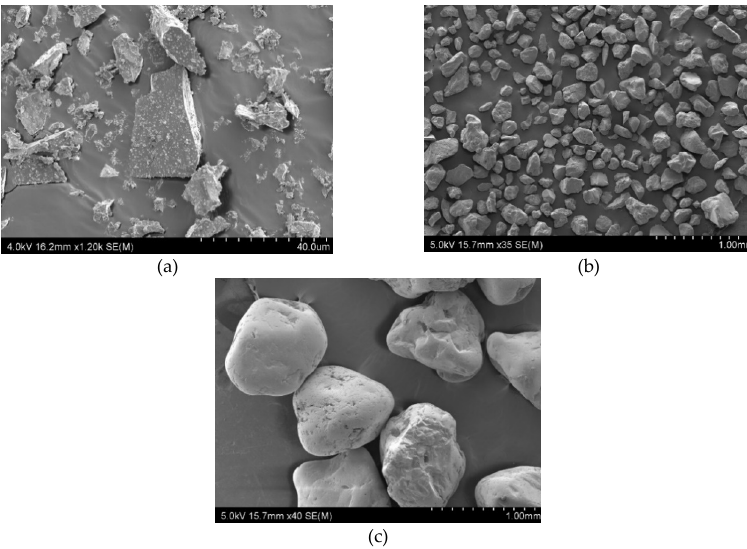
Figure 1. Morphology of powder particles used in the sample molds: ( a ) quartz meal; ( b ) silica sand 0.1–0.3 mm; and ( c ) silica sand 0.5–1.0